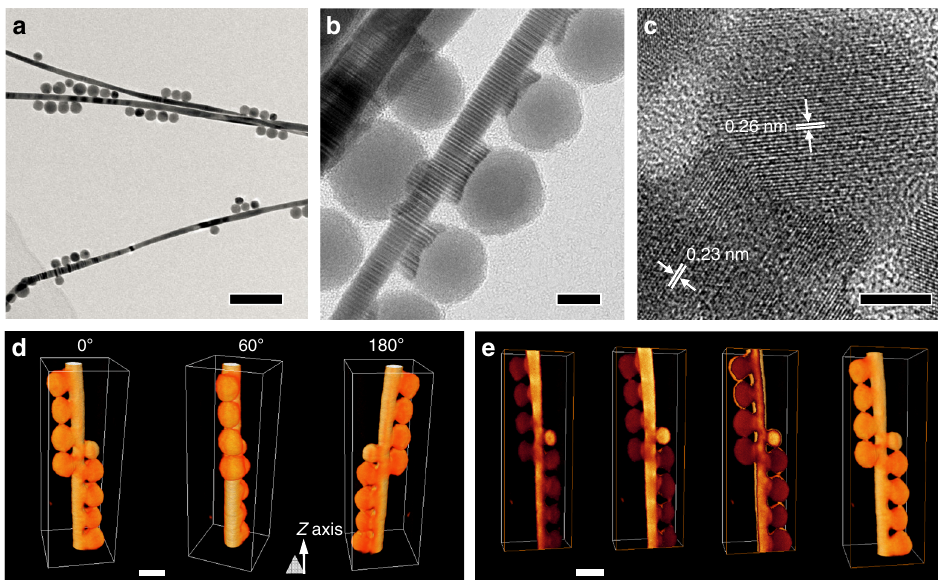
Fig. 5 Formation of Au – Ag 2 S tree burl-like HNPs through welding of Au NWs and spherical Ag 2 S NPs. a – c TEM images of HNPs obtained by welding Ag 2 S NPs and Au NWs at different magni fi cations. d The volume renderings of the tomographic reconstruction of such HNPs at different rotation angles along Z axis. e Three-dimensional tomographic reconstruction of such Au – Ag 2 S HNPs. The progressing cross-sections and the isosurfaces visualize the internal structures of the nanocomposite. Scale bars are 100 nm in a , 10 nm in b , 5 nm in c , and 20 nm in d and